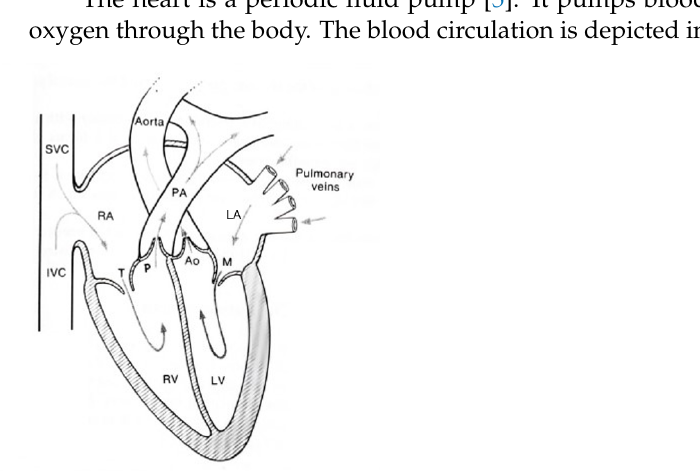
Figure 1. Blood flow circulation through heart chambers, valves, arteries, and veins. Adapted with permission from [9]. © 1990, Springer Science+Business Media New